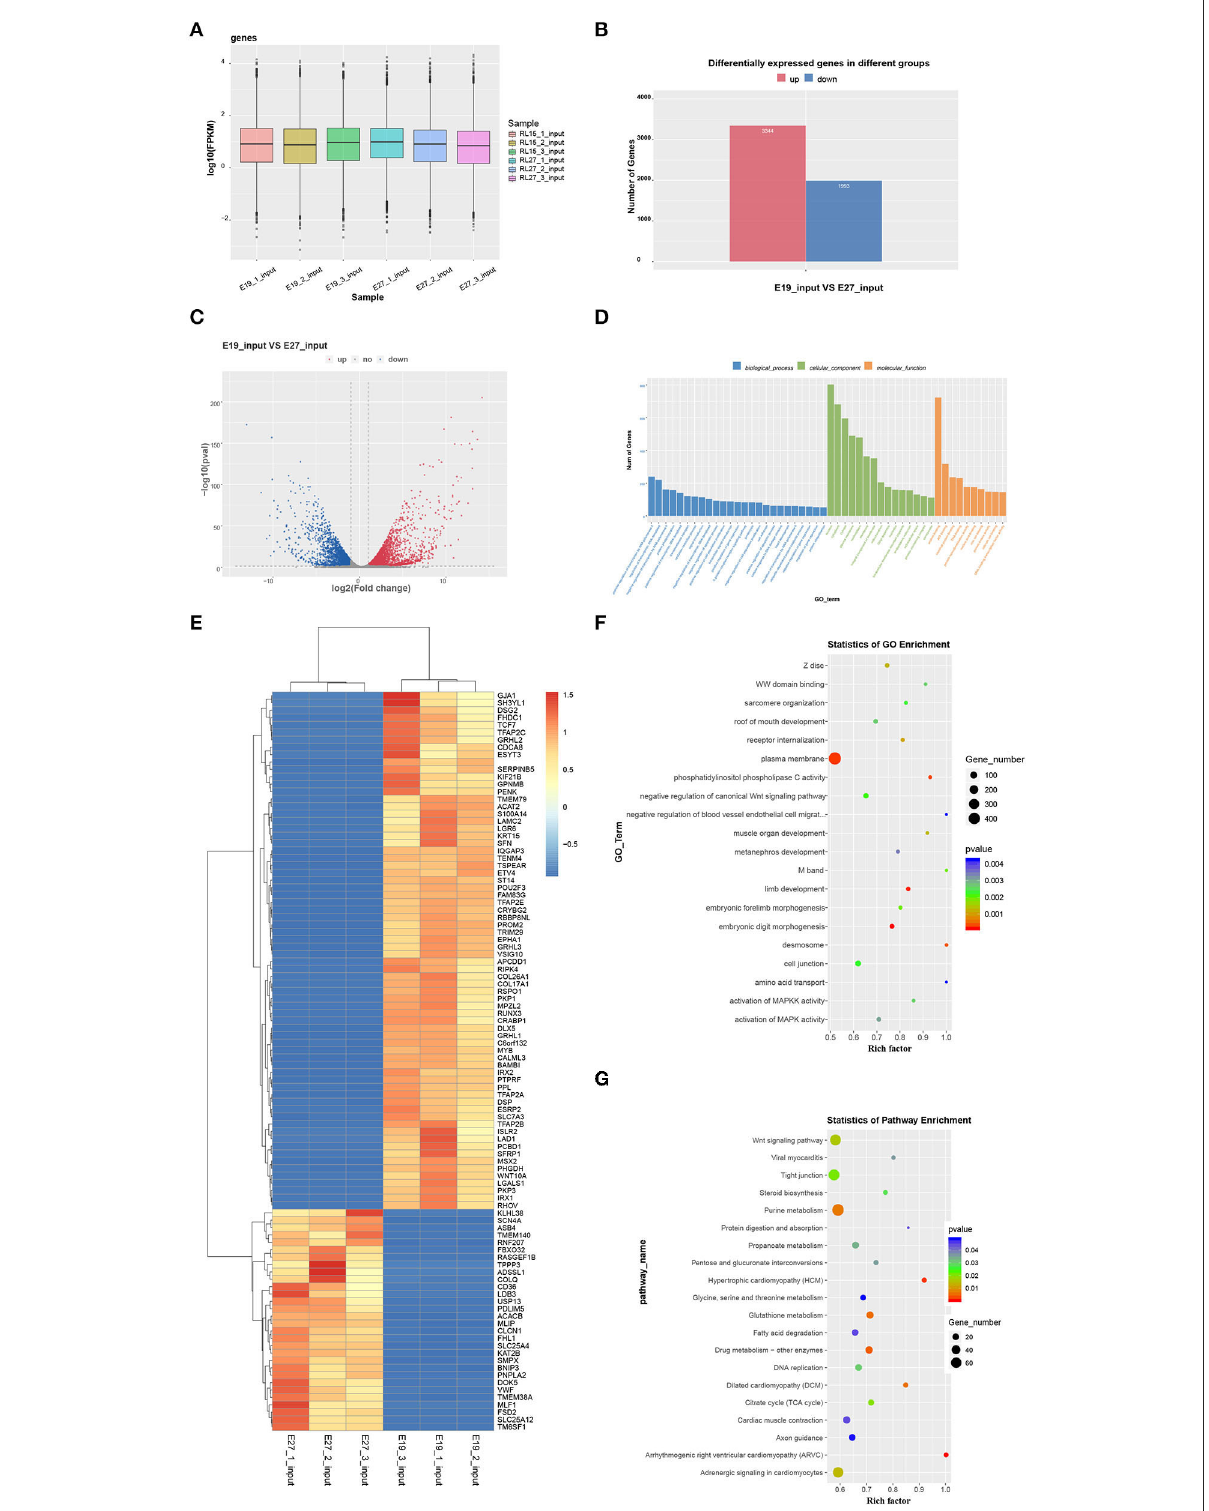
FIGURE4 Global gene expression in the two stages and GO and KEGG analyses of DEGs. (A) Global expression levels of expressed genes. (B) Number of upregulated and downregulated DEGs between the two stages. (C) Volcanic map of DEGs. (D) Heatmap of DEGs. (E) Statistics of GO enrichment. (F) GO analysis of DEGs. (G) KEGG analysis of